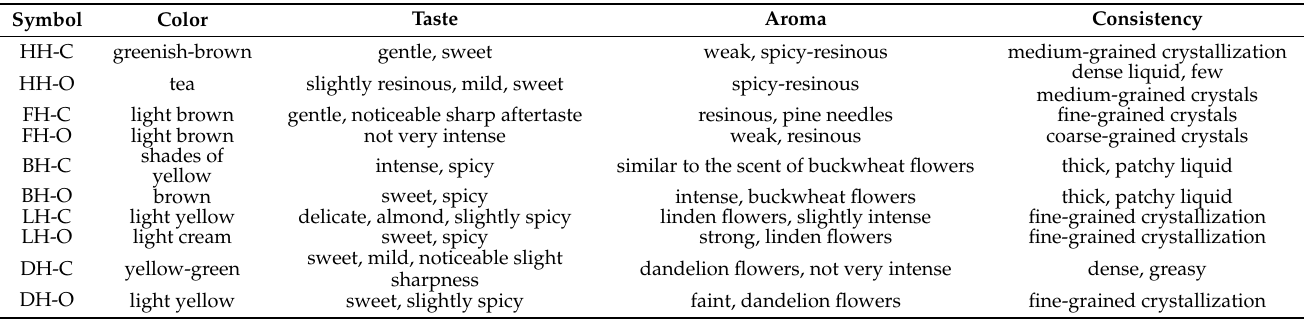
Table 3. Organoleptic properties of